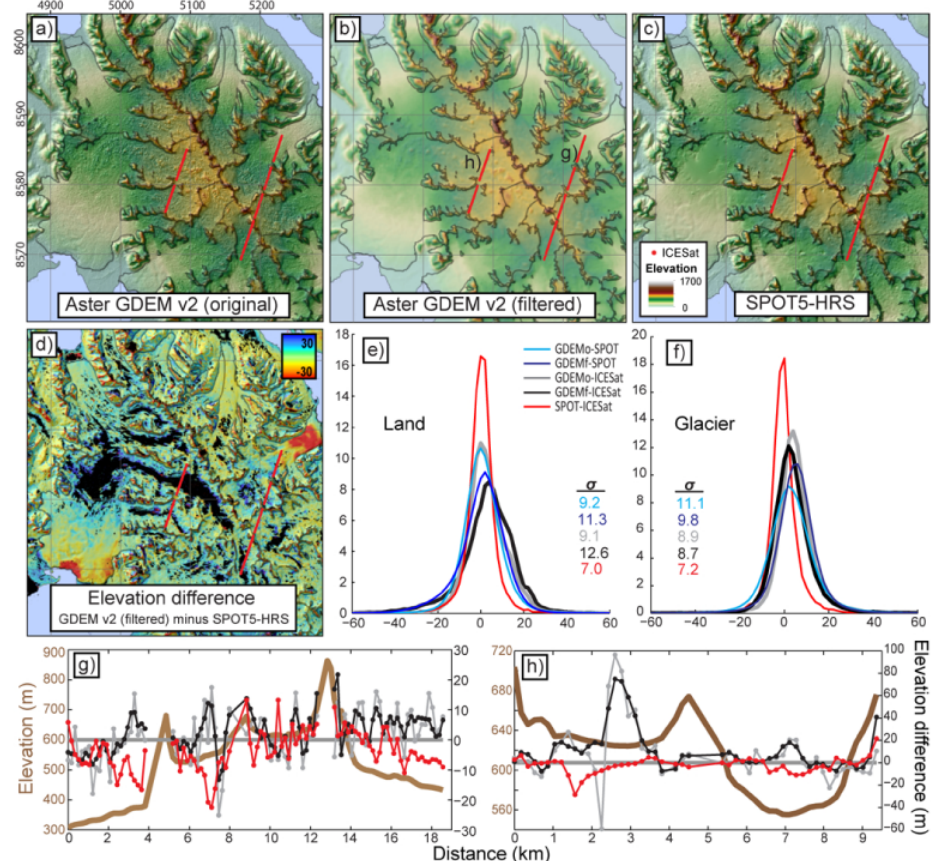
Fig. A1. (a) Hillshades draped by elevation for the original ASTER GDEM, (b) the Fourier-filtered GDEM, and (c) a 2008 SPOT5-HRS DEM. (d) The differences between the filtered GDEM and the SPOT DEM with the black areas containing correlations that are less than 40. (e) and (f) show normalized histograms ( y axis as percentage of pixels) of elevation differences ( x axis in meters) for land and glaciers, respectively, for the DEMs and ICESat. In the legend of (e) , “GDEMo” and “GDEMf” are the original and filtered GDEM, respectively. (g) and (h) show two individual ICESat profiles over higher-elevation glacier regions (typical for low visible contrast areas) from 27 May 2005 and 19 March 2008, respectively, with their differences to the three DEMs. The thick brown line shows the topography, while the other colored lines correspond to the labels presented in (e)